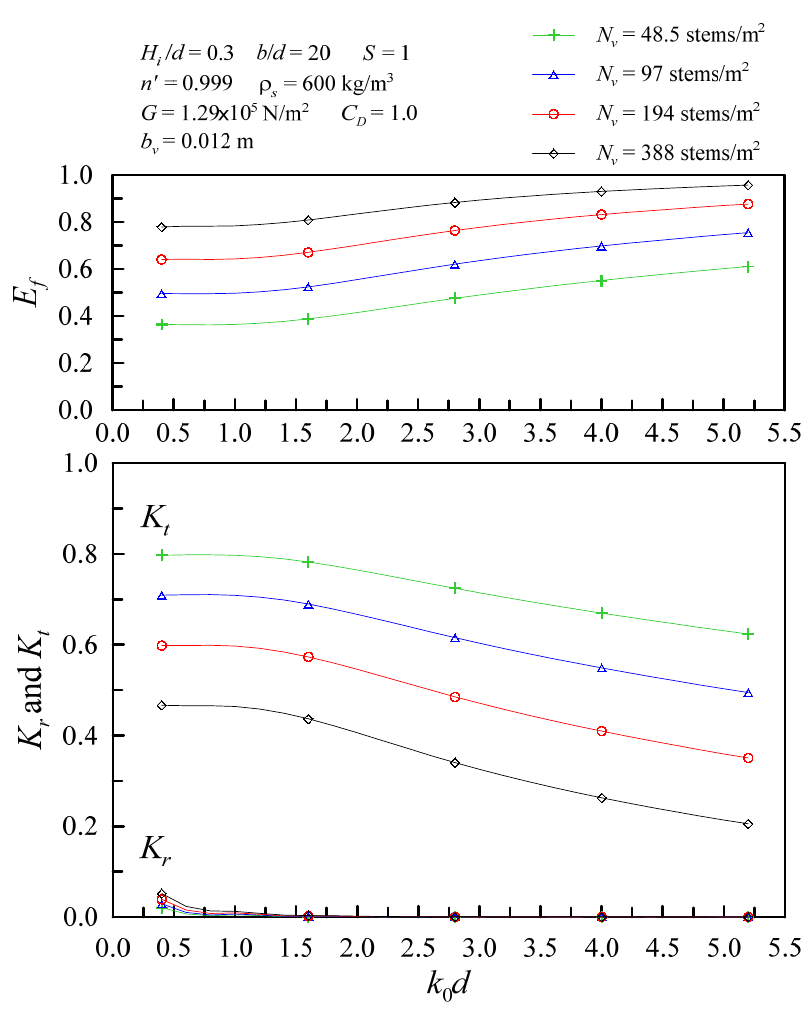
N of vegetation on K , K , and Figure 8. E ff ect of the stem density N v of vegetation on K r , K t , and E f ( H i / d = 0.3, d = 0.3 m, b / d = v r t